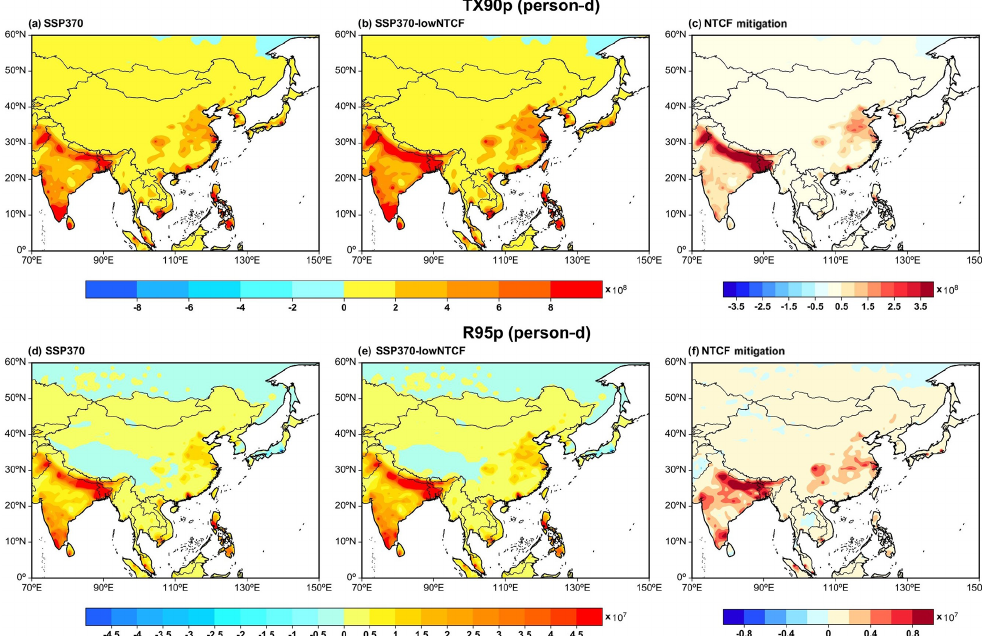
Figure 12. Spatial patterns of changes in population exposed to warm days (TX90p) and total wet days (R95pdays) in Asia during 2031–2050 under the SSP3-7.0 (a, d) and SSP3-7.0-lowNTCF (b, e) scenarios relative to 1995–2014 (units: person-days). Panels (c) and (f) represent the changes caused by the non-methane SLCF reductions.